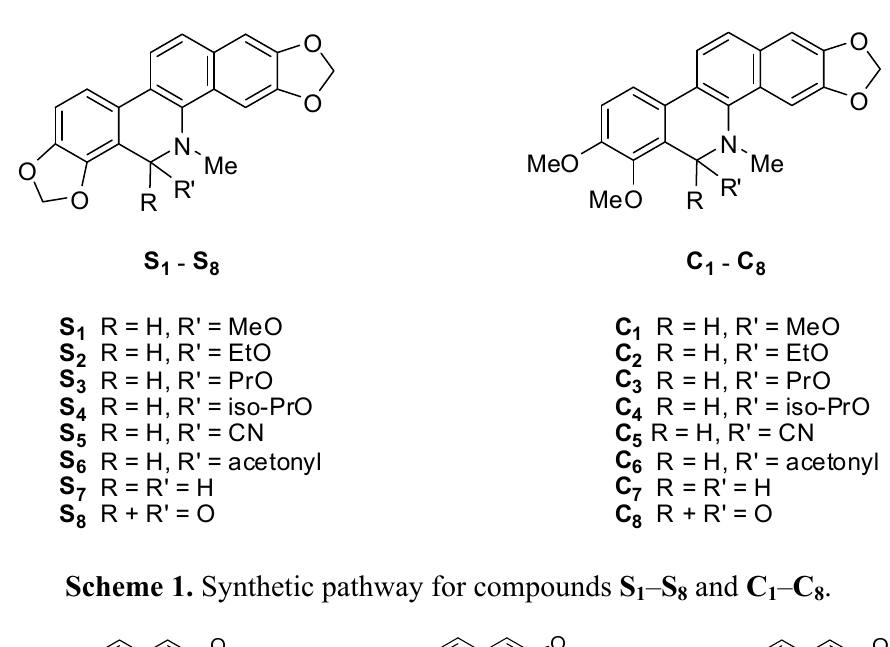
– S and chelerythrine C 1 8